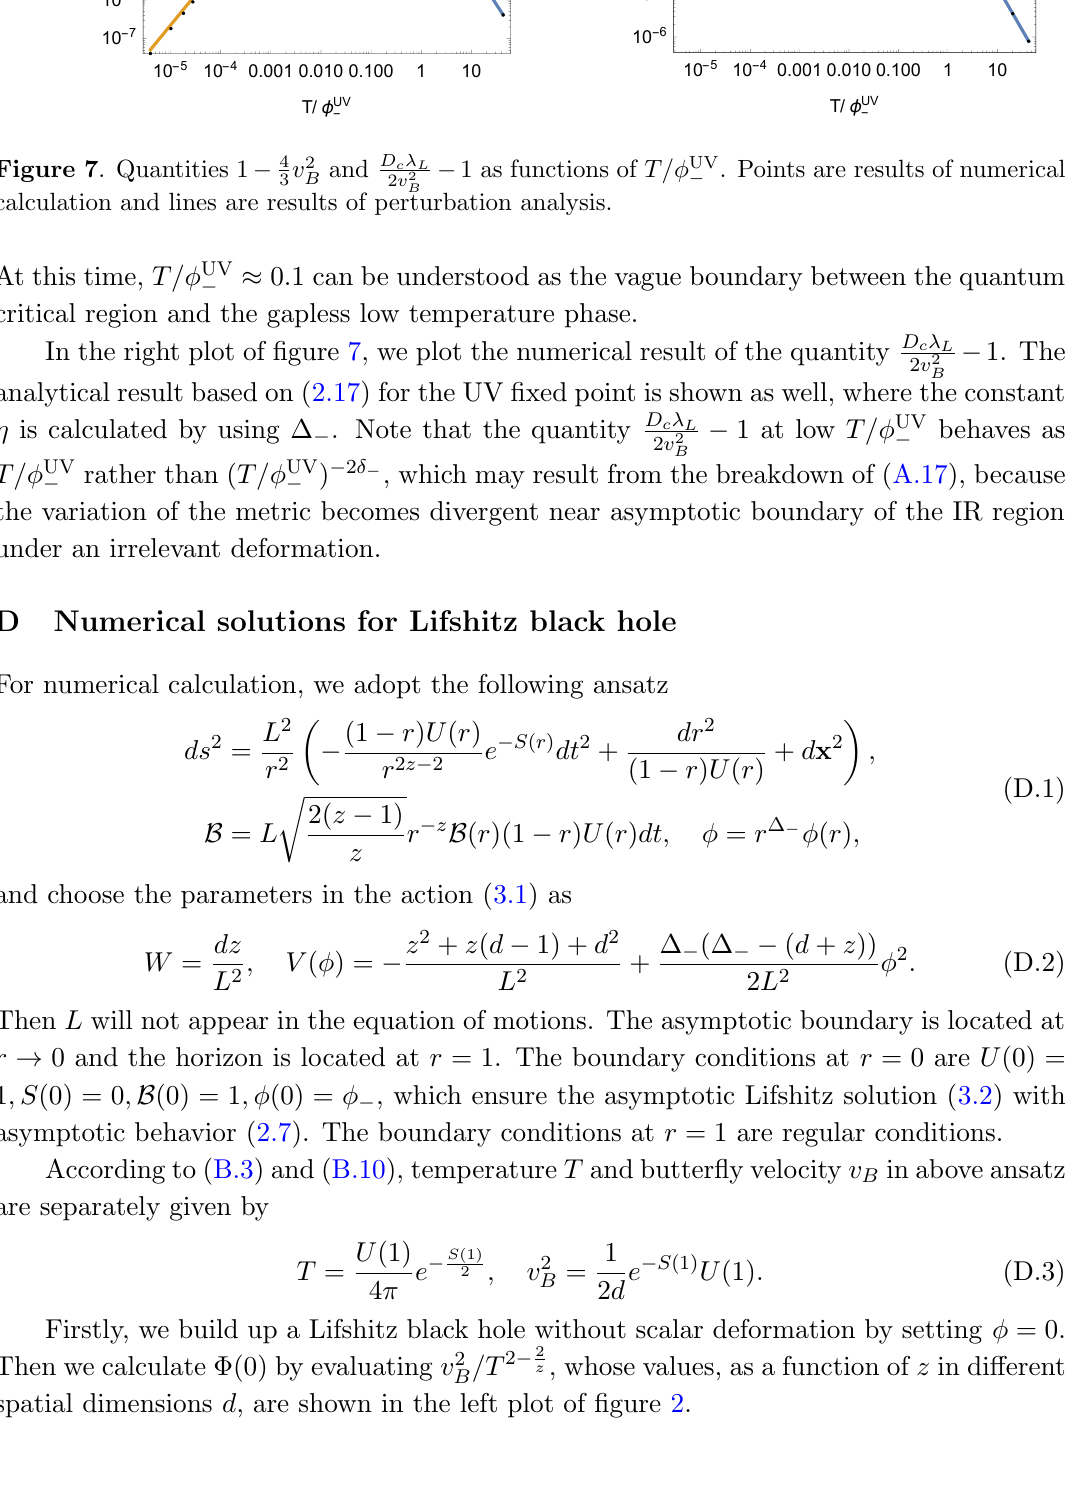
. Points are results of numerical (cid:0)